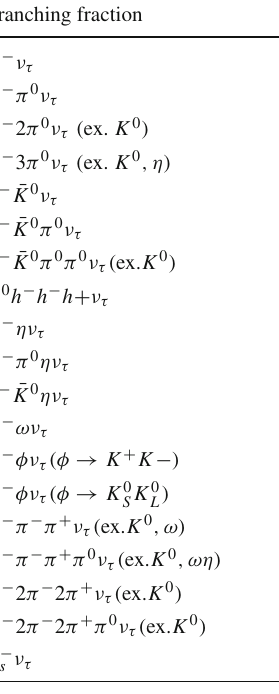
Table 316 HFLAV Spring 2017 τ branching fractions to strange